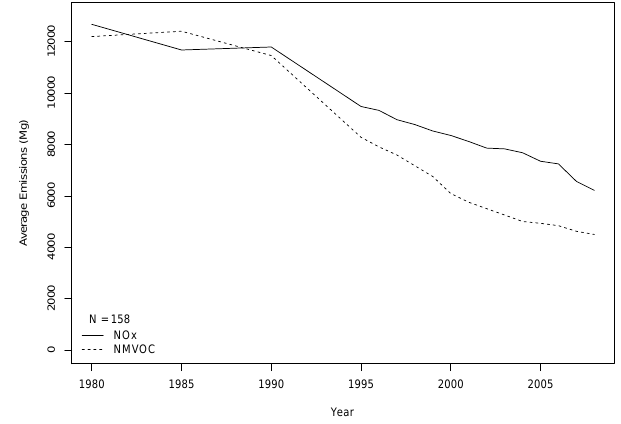
Fig. 2. The average anthropogenic NO x and NMVOC emissions